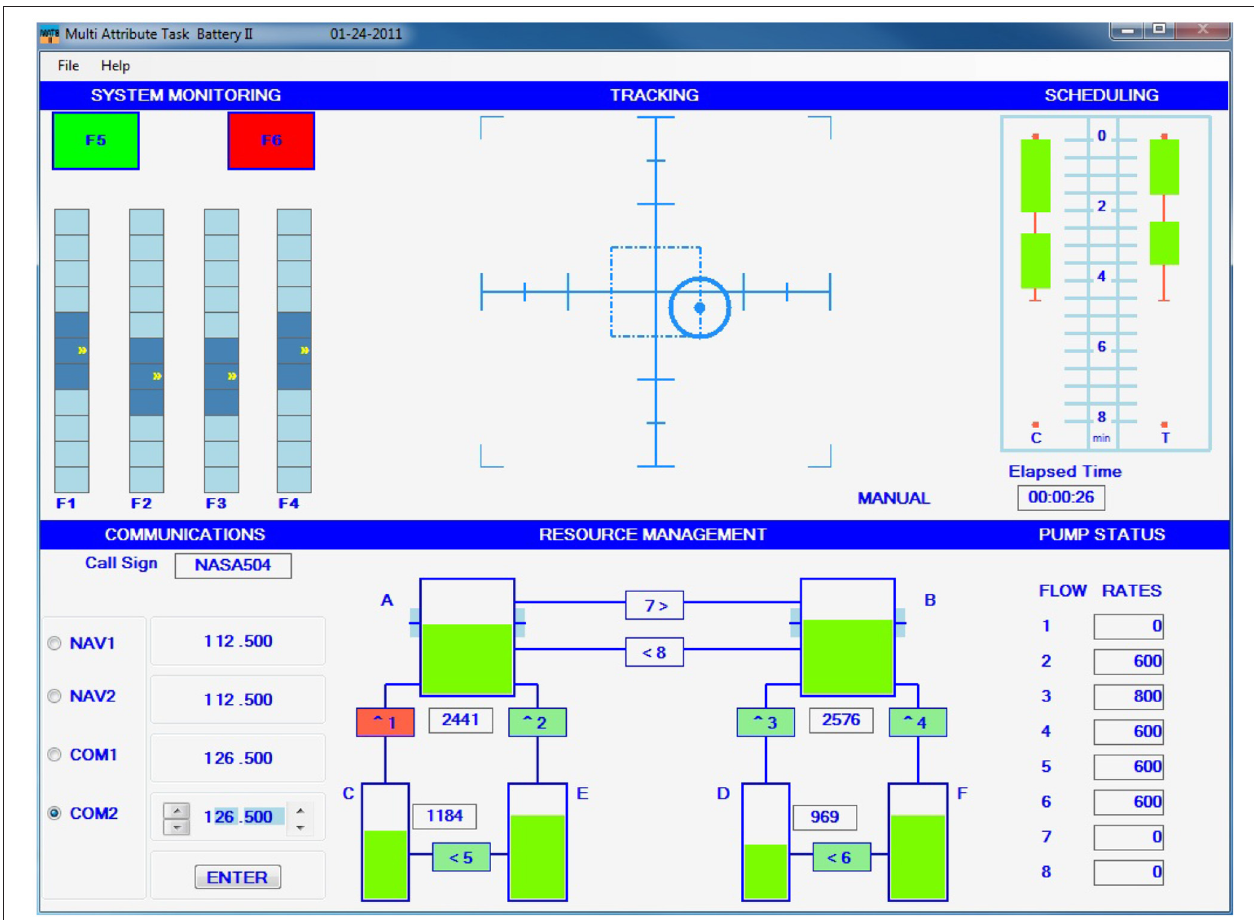
FIGURE 1 | Graphical interface of the MATB-II software used to modulate high and low MW